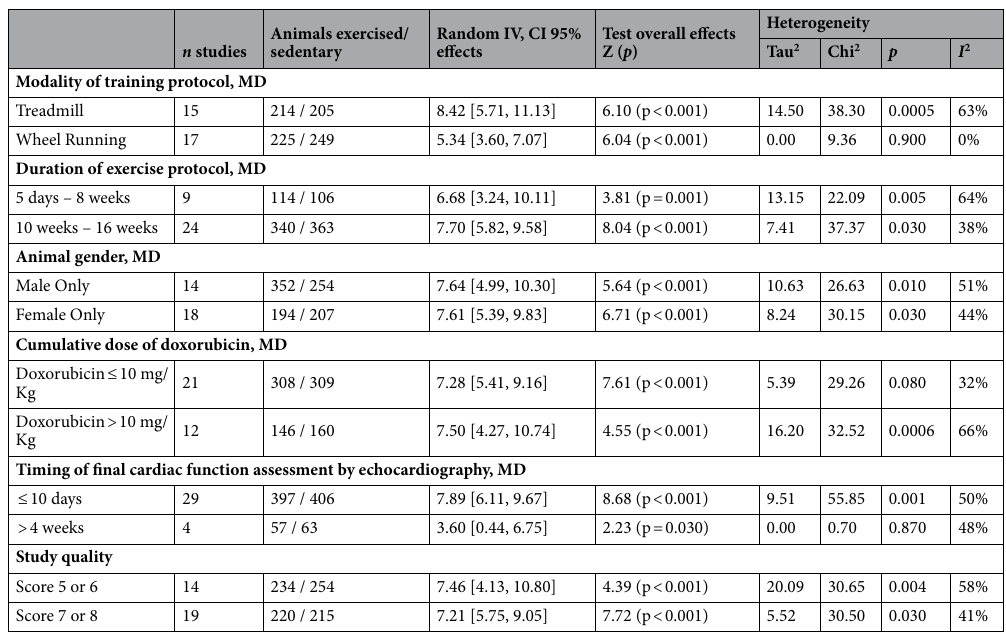
Animals exercised/ sedentary